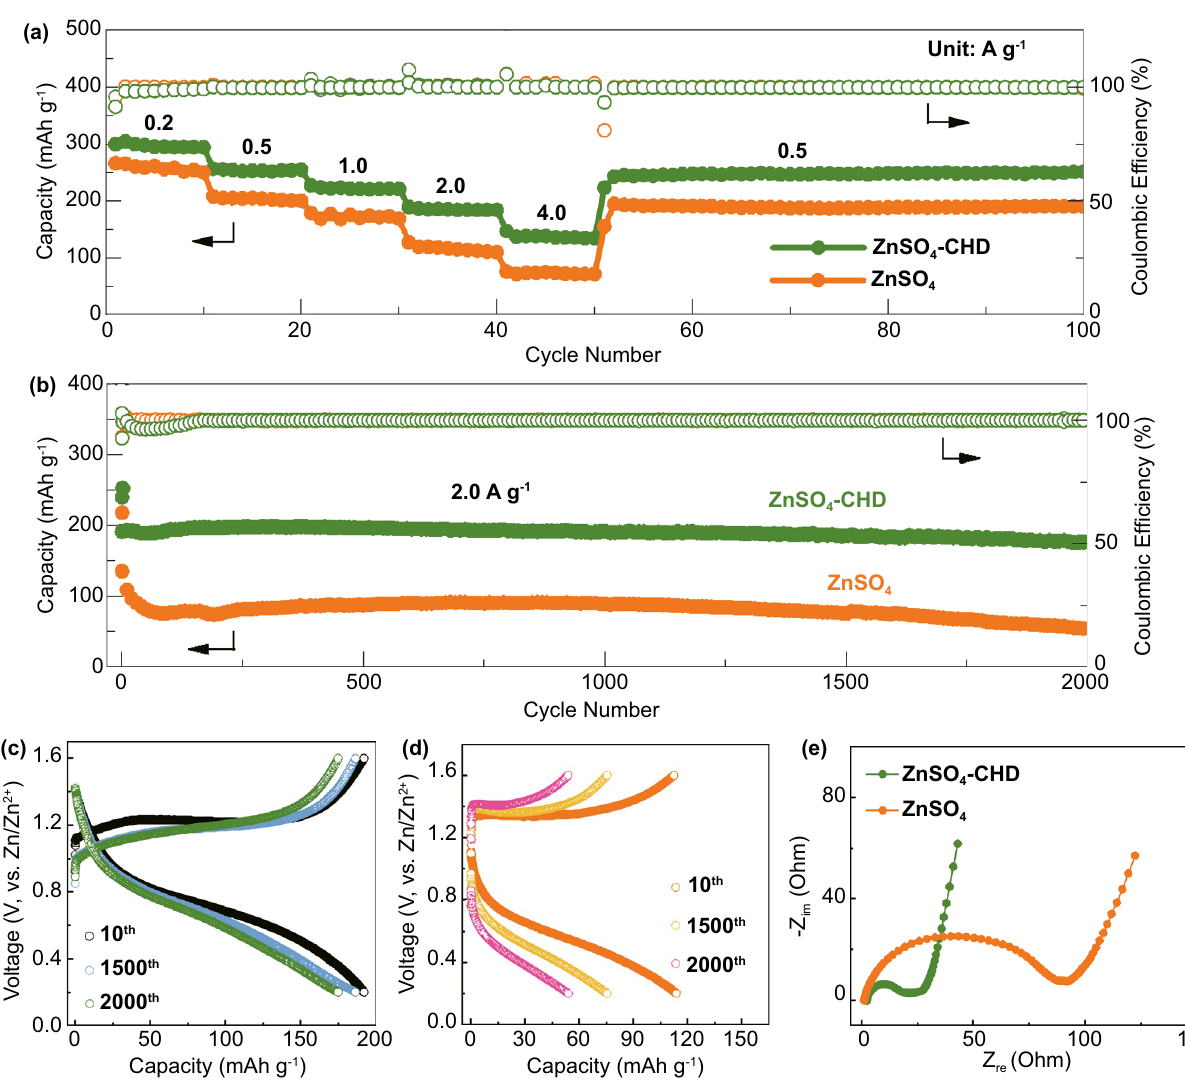
Fig. 6 The Zn|V 2 O 5 full cells performance with and without the CHD additives: a Rate performance from 0.2 to 4.0 A g −1 . b Long‑term cycling performance at 2.0 A g −1 after the activation at 0.2 A g −1 for three cycles. c, d Voltage profiles at 2.0 A g −1 for the 10th, 1500 th , and 2000th cycle with ( c ) and without ( d ) CHD additives. e EIS test with and without CHD additives after the 10th cycle at 200 mA g